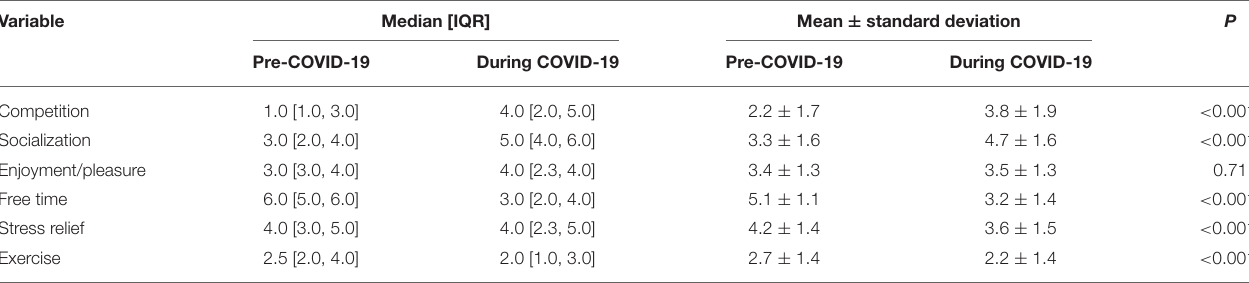
TABLE 2 | Differences in motivation factors pre- and during COVID-19 social distancing restrictions.